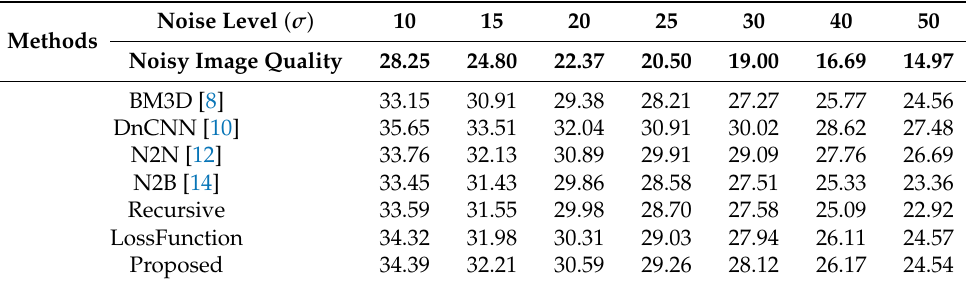
Table 1. Comparison of denoising performance for noisy image with fixed-level